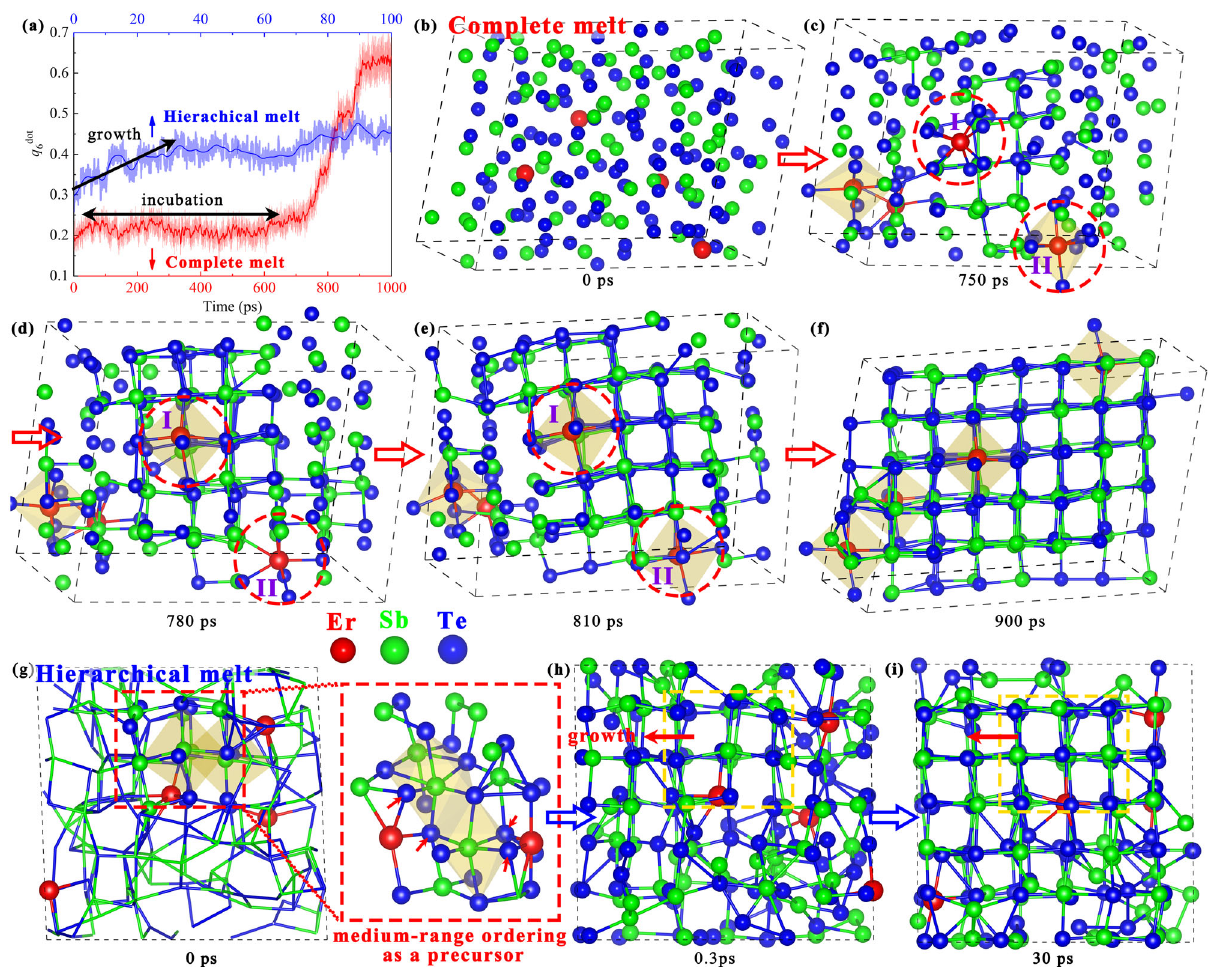
Fig. 5 Hierarchical melt tuned crystallization. a The evolution of q 6 dot value during the crystallization for the complete melt (red) and hierarchical melt (blue) models. In the complete model, b – f show the snapshots at 0 ps, 750 ps, 780 ps, 810 ps, and 900 ps, respectively, where the octahedral environment around Er atoms is characterized by orange octahedral cages. The crystal-like atoms and their neighbor atoms are connected by bonds with the cutoff of 3.6 Å. The red circles in c – e emphasize the alterable Er local environments. In the hierarchical melt model, g – i show the snapshots at 0 ps, 0.3 ps, and 30 ps,